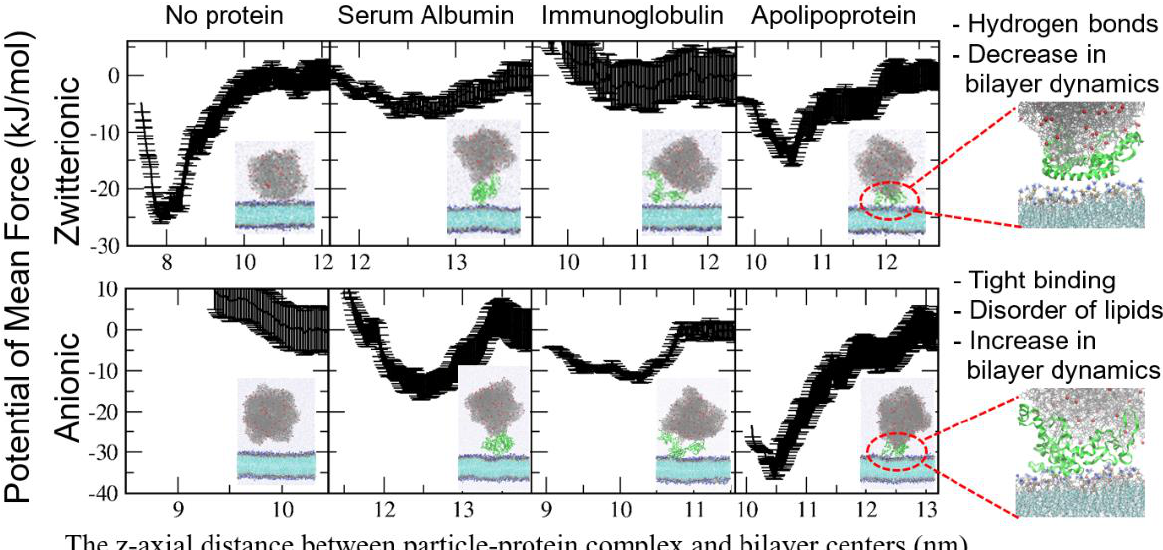
Figure 11. Free energy calculations of the 10 nm-sized PS particle complexed with plasma proteins adsorbed onto zwitterionic and anionic leaflets of lipid membrane. Reproduced with permission from [66], American Chemical Society, 2021.